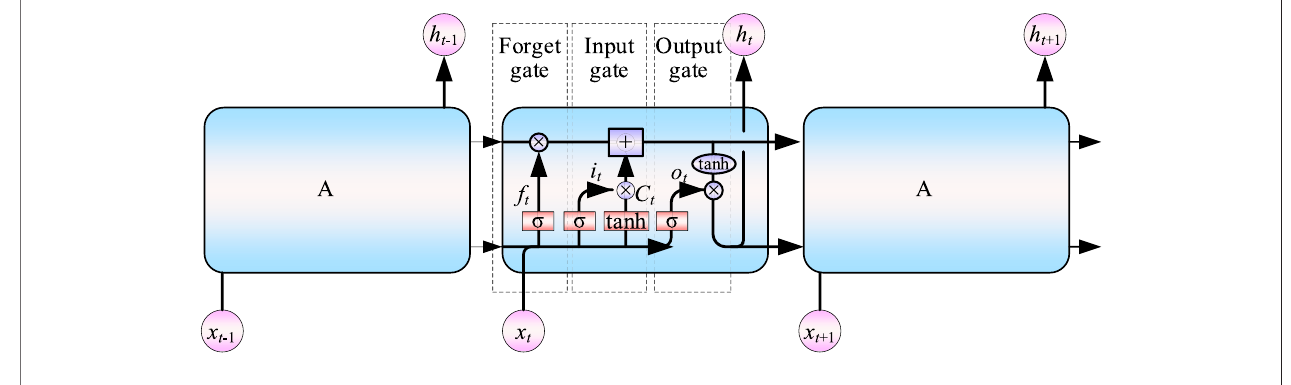
FIGURE 1 | Network structure of the RNN.